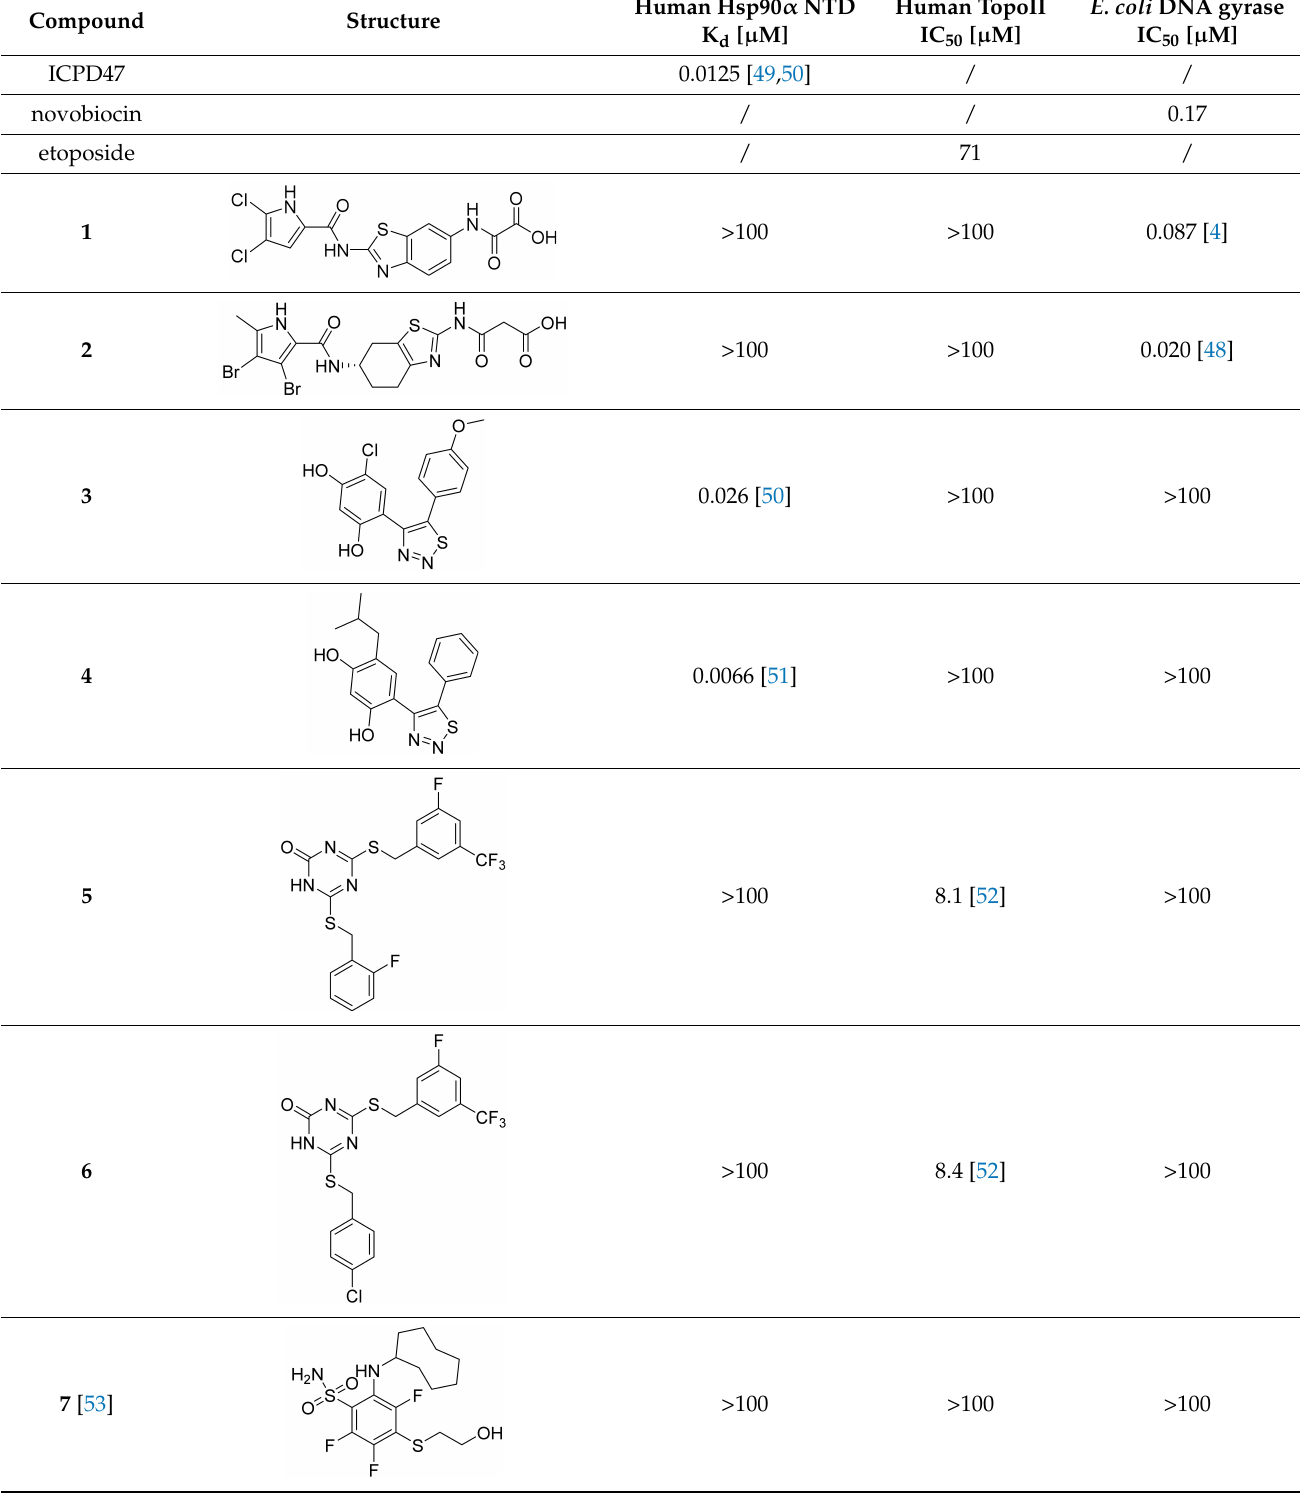
Table 1. Experimental in vitro activity profiling of DNA gyrase inhibitors 1 and 2 , Hsp90 α NTD inhibitors 3 and 4 , TopoII α inhibitors 5 and 6 , and carbonic anhydrase IX inhibitor 7